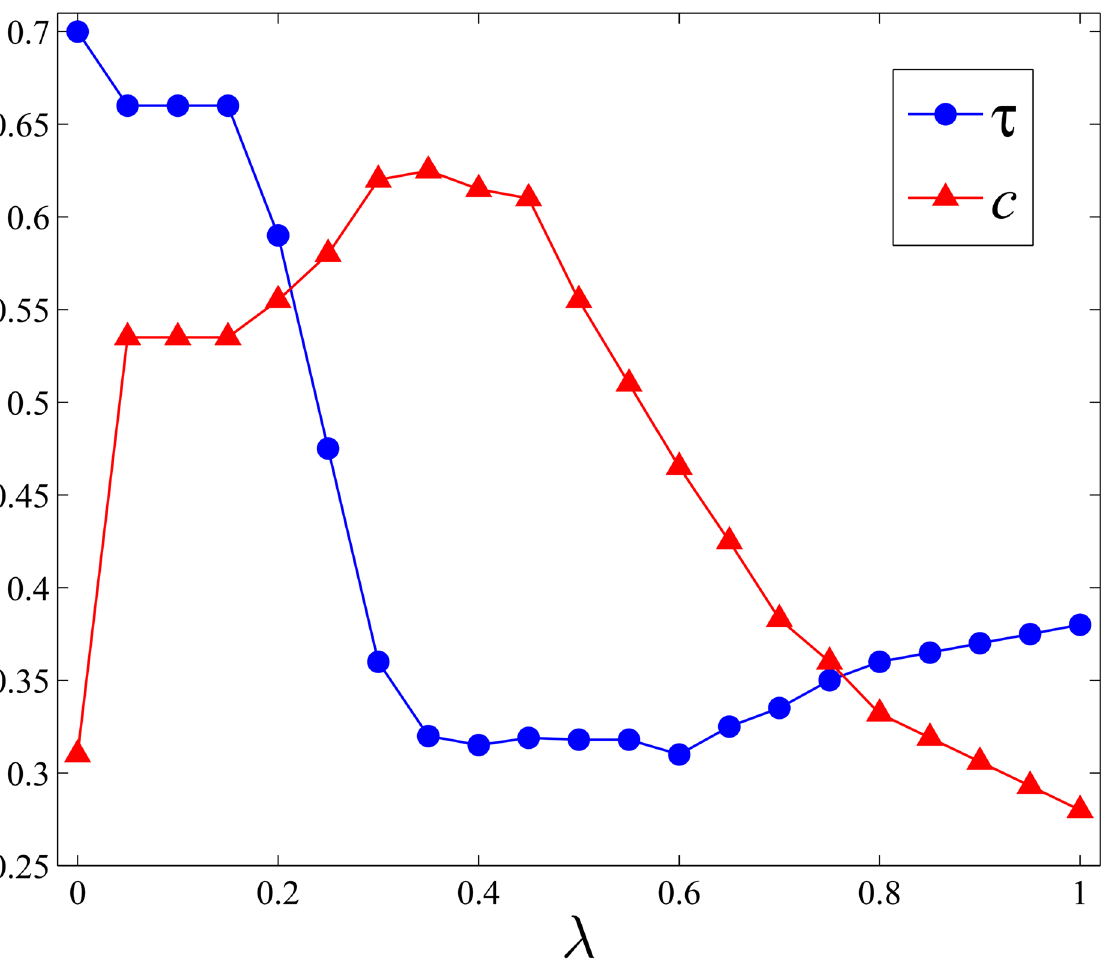
Fig 5. Evolutions of different λ . The size of the network is 1000 and the initial average degree is 4. 10000 new links have been added to guarantee the stability of the results for each λ